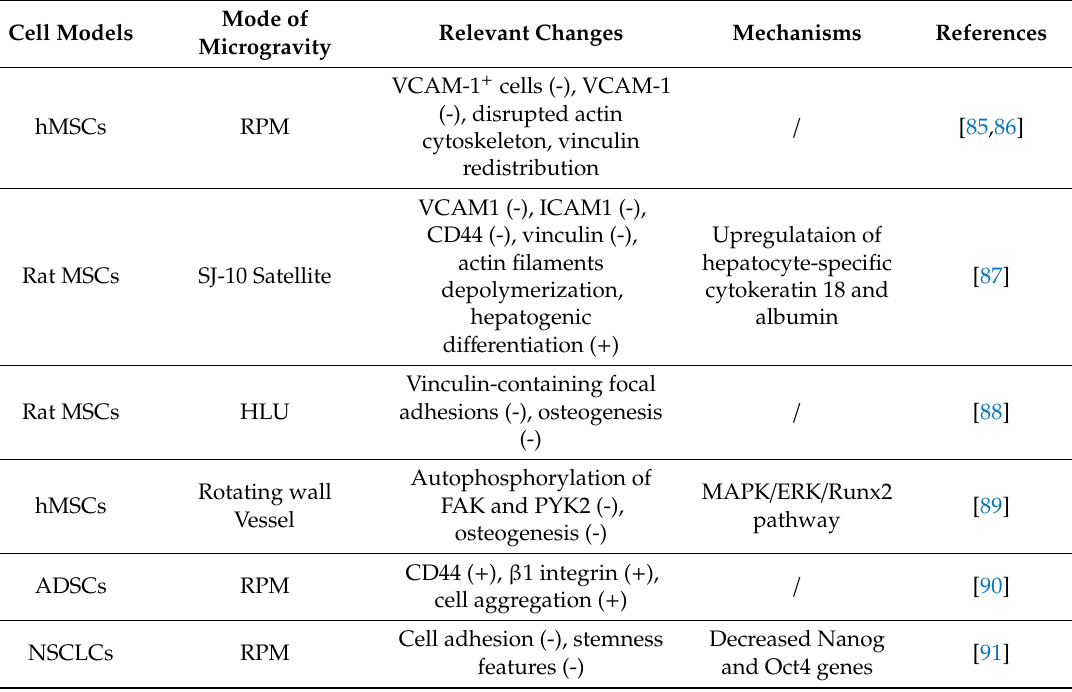
Table 5. E ff ects of microgravity on stem cells